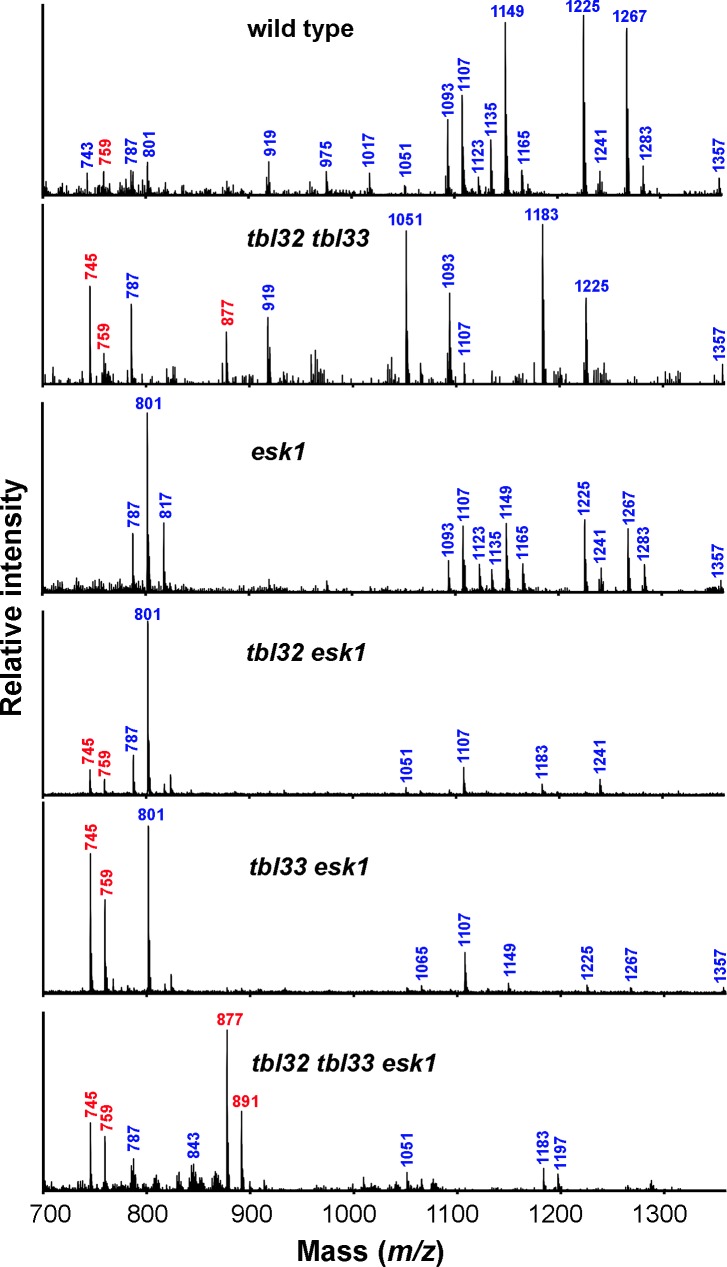
MALDI-TOF MS analysis of acetylated xylans of the wild type and various mutants.DMSO-extracted xylans were digested with endoxylanase and subject to MALDI-TOF MS. The major ion peaks of masses are indicated and their xylooligomer structures are listed below. Xyln(GlcA)n(Ac)n denotes a xylooligomer (with n number of xylosyl residues) substituted with n number of GlcA and n number of acetyl groups. m/z 743, Xyl5(Ac); m/z 745, Xyl4(GlcA); m/z 759, Xyl4(MeGlcA); m/z 787, Xyl4(GlcA)(Ac); m/z 801, Xyl4(MeGlcA)(Ac); m/z 817, Xyl3(MeGlcA)2; m/z 843, Xyl4(MeGlcA)(Ac)2; m/z 877, Xyl5(GlcA); m/z 891, Xyl5(MeGlcA); m/z 919, Xyl5(GlcA)(Ac); m/z 975, Xyl5(MeGlcA)(Ac)2; m/z 1017, Xyl5(MeGlcA)(Ac)3; m/z 1051, Xyl6(GlcA)(Ac); m/z 1065, Xyl6(MeGlcA)(Ac); m/z 1093; Xyl6(GlcA)(Ac)2; m/z 1107; Xyl6(MeGlcA)(Ac)2; m/z 1123, Xyl5(MeGlcA)2(Ac); m/z 1135, Xyl6(GlcA)(Ac)3; m/z 1149, Xyl6(MeGlcA)(Ac)3; m/z 1165, Xyl5(MeGlcA)2(Ac)2; m/z 1183, Xyl7(GlcA)(Ac); m/z 1197, Xyl7(MeGlcA)(Ac); m/z 1225, Xyl7(GlcA)(Ac)2; m/z 1241, Xyl6(GlcA)(MeGlcA)(Ac); m/z 1267, Xyl7(GlcA)(Ac)3; m/z 1283, Xyl6(GlcA)(MeGlcA)(Ac)2; m/z 1357, Xyl8(GlcA)(Ac)2. Note the increase in the abundance of ions at m/z 745, 759, 877, and 891 (marked in red) corresponding to non-acetylated xylooligomers in tbl32 tbl33, tbl32 esk1, tbl33 esk1, and tbl32 tbl33 esk1.